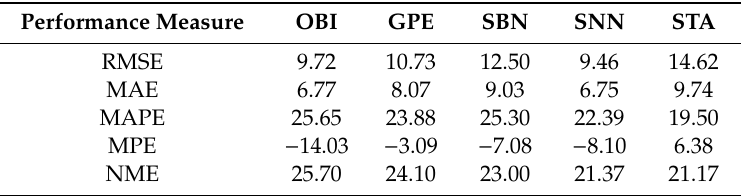
Table 11. Performance measures over 30 left-out days (120 times of the day). The forecast performance does not decay in the out-of-sample interval (see Table